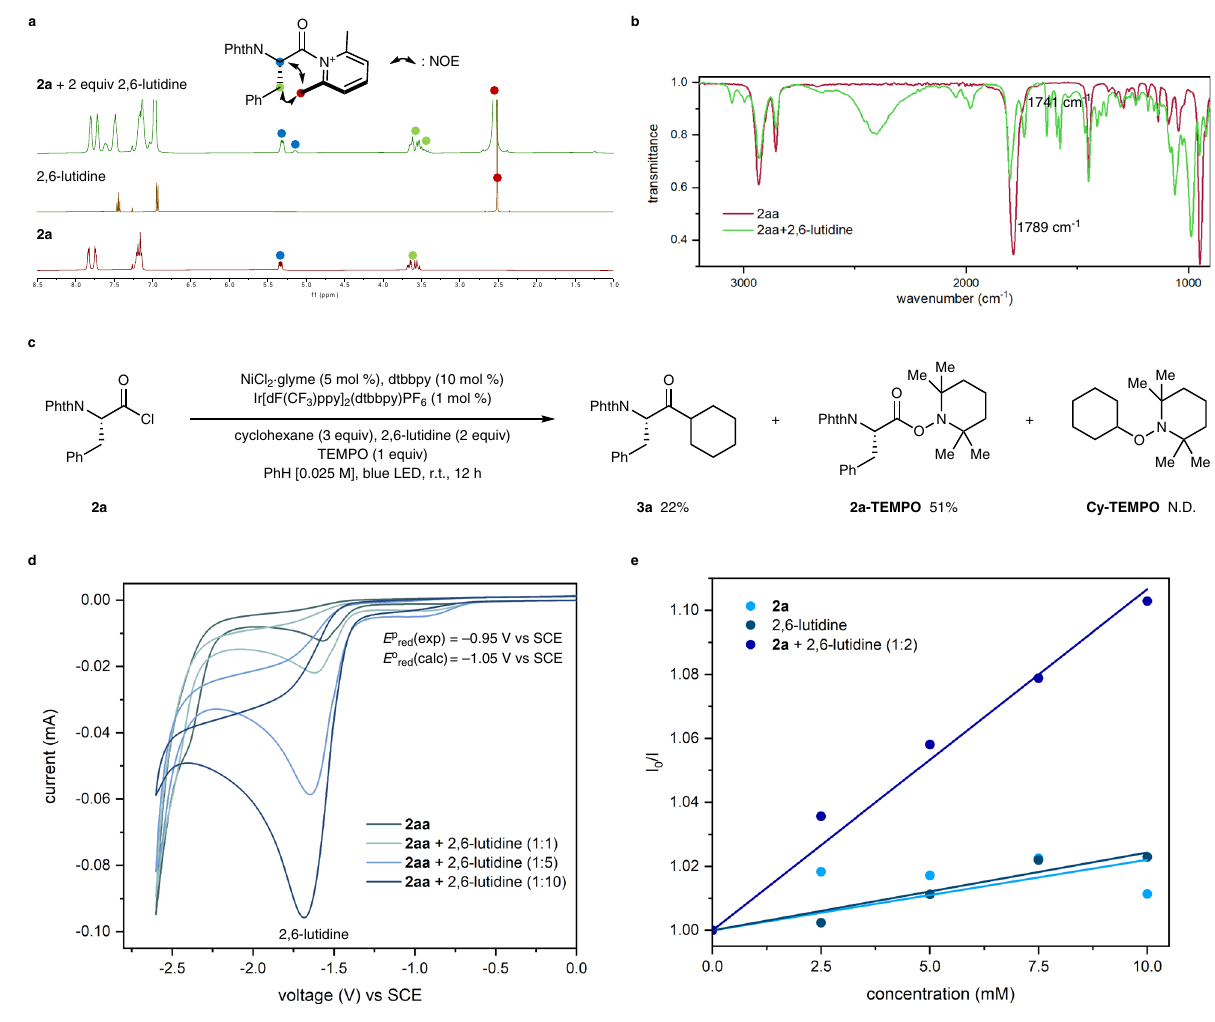
Fig. 4 | Mechanistic studies. a NMR studies. b IR studies. c Radical scavenger experiment. Yields were determined using 1 H NMR spectroscopy with 1,1,2,2-